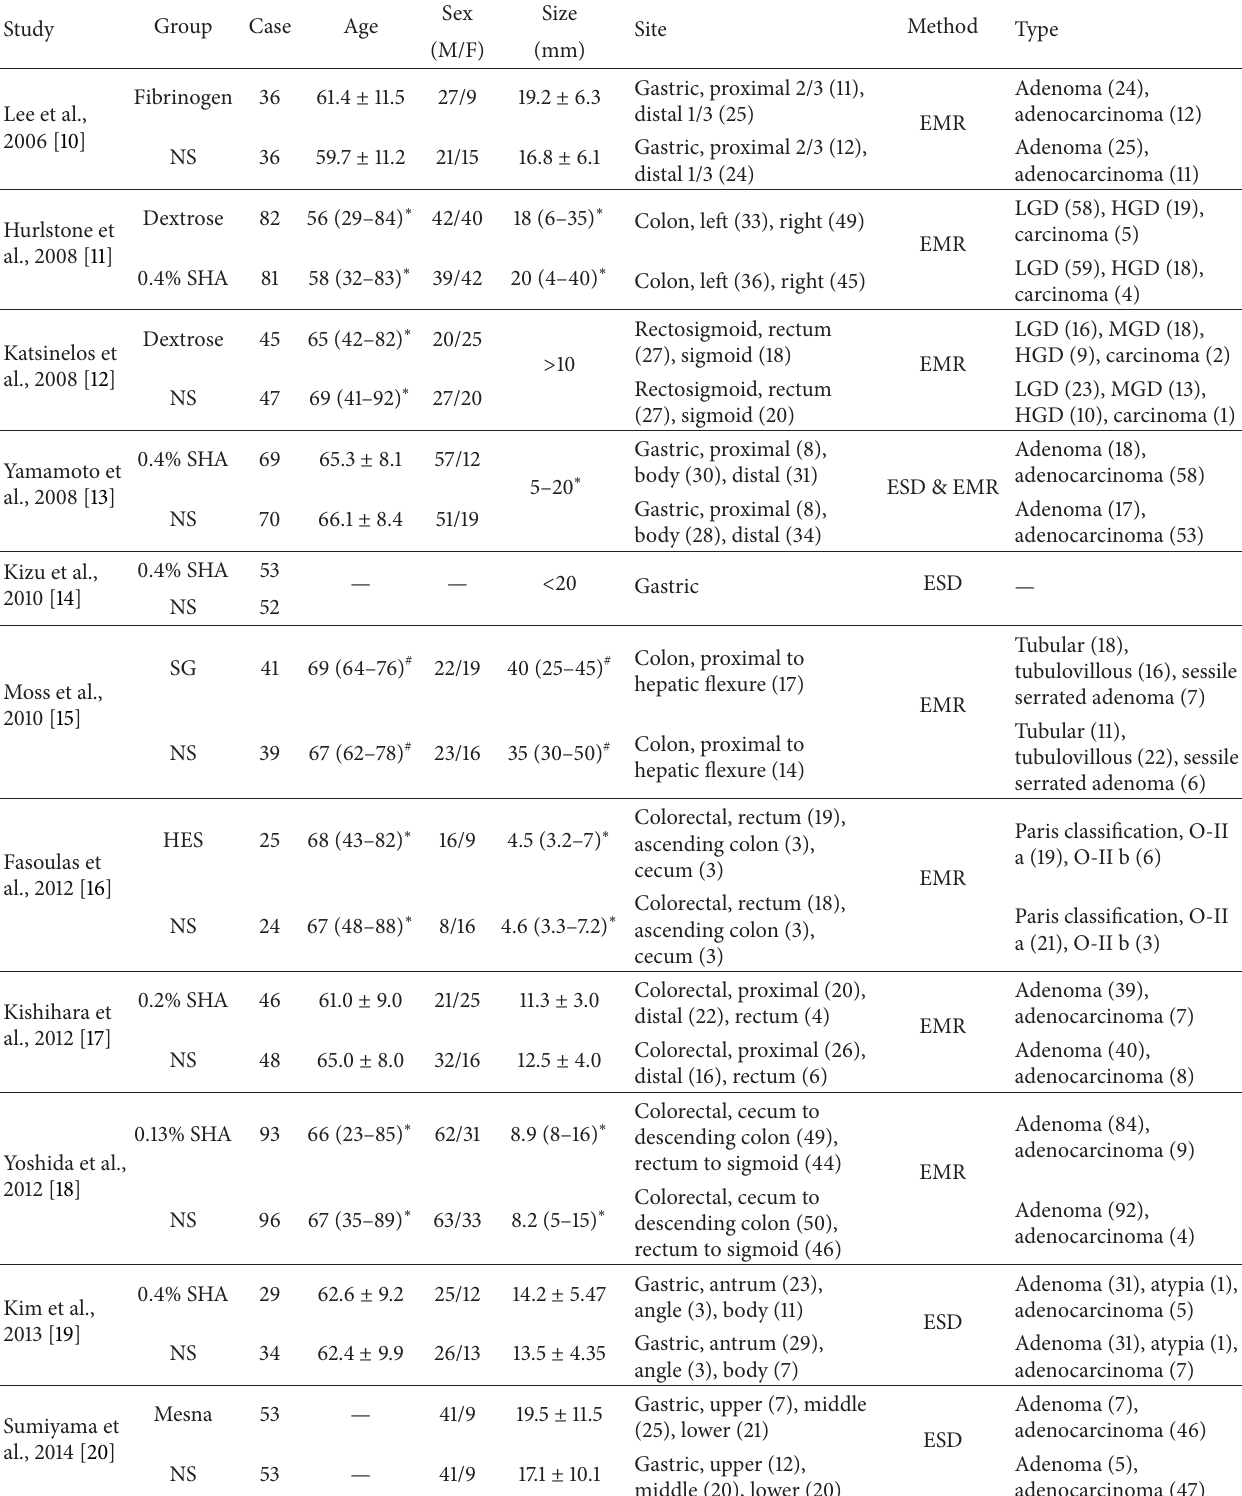
Table 1: Characteristics of